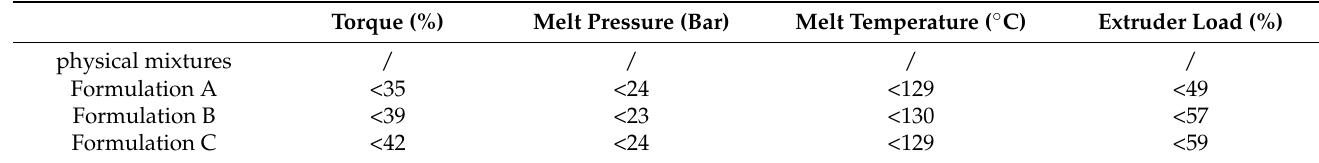
Table 1. Output critical process parameters of the Twin Screw Extruder.